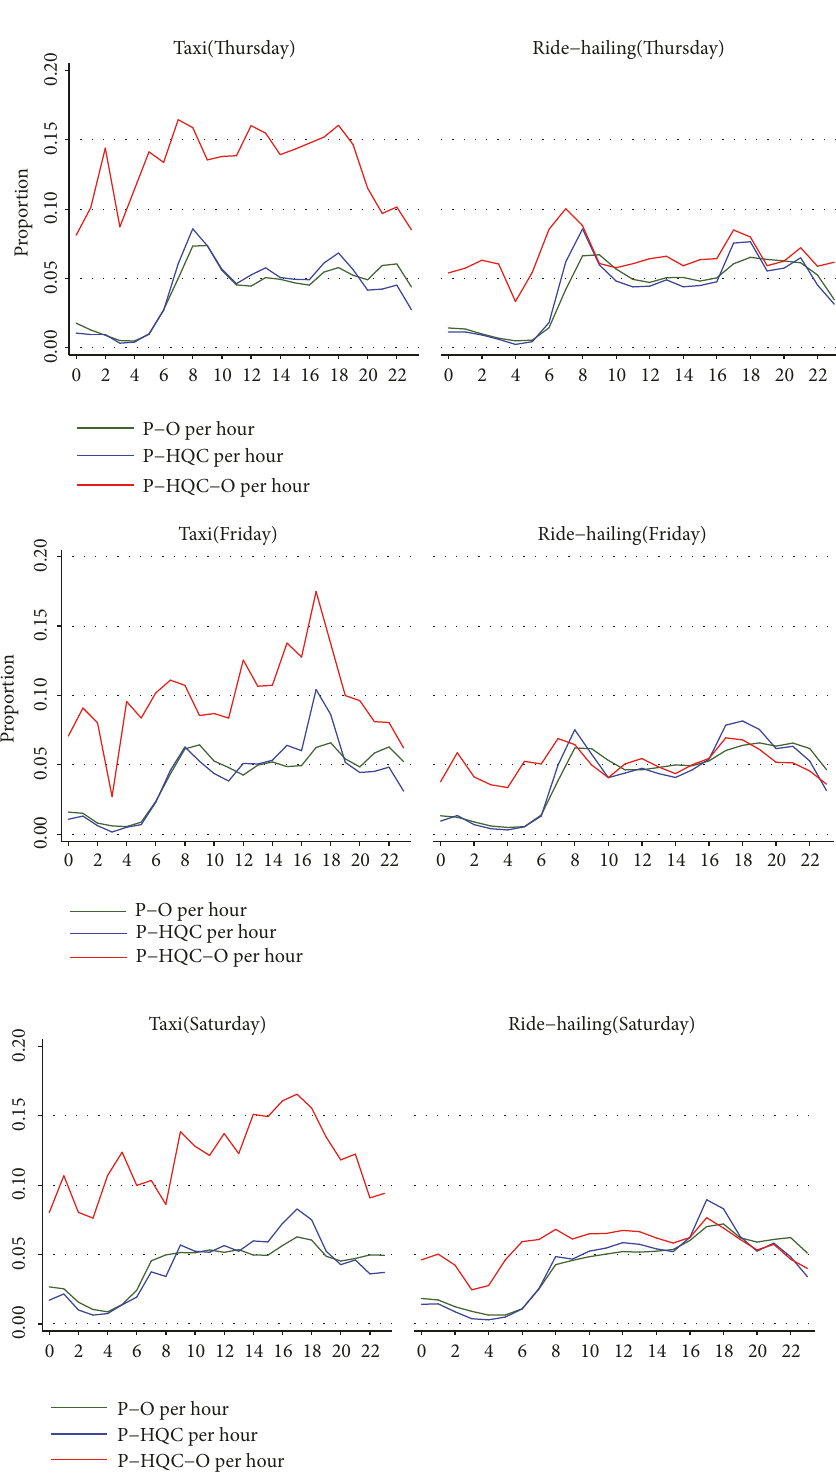
Figure 4: The temporal distribution of taxi (ride-hailing) orders and